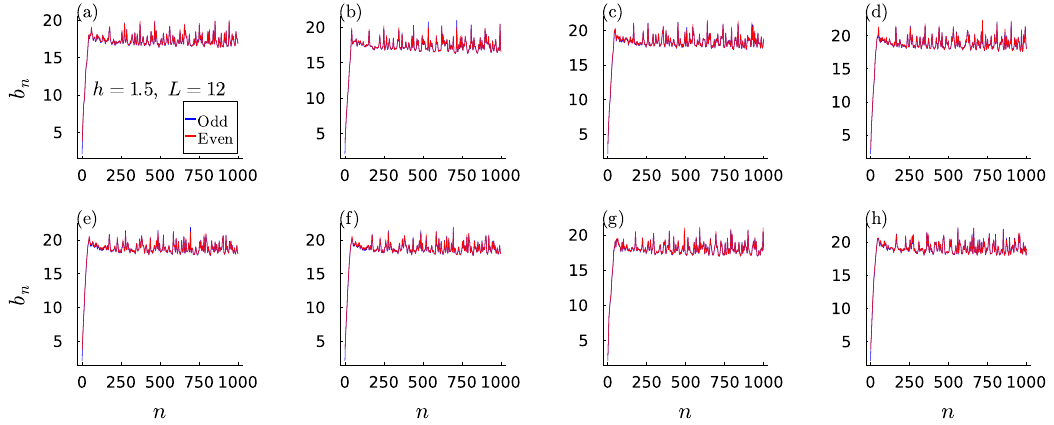
Figure 15: (a)-(h)Disorder realizations of the Lanczos coefficients b h = 1.5 (ergodic